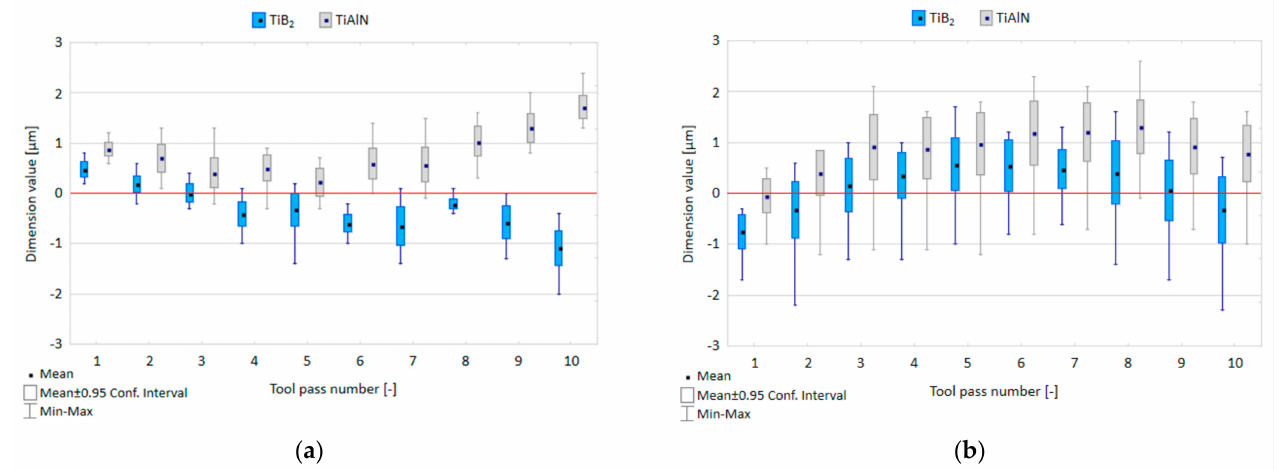
Figure 7. Dimensional accuracy obtained in: ( a ) precision milling, ( b ) conventional milling performed using the tools with TiB 2 and TiAlN